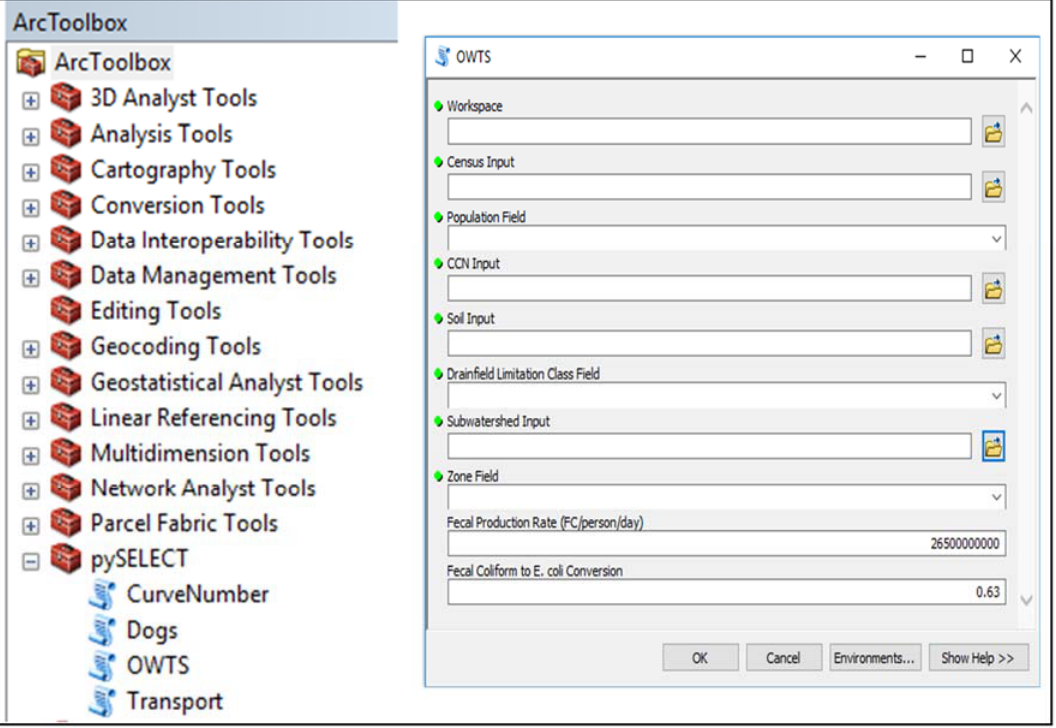
Figure 1. Example of pySELECT graphical user interface (GUI) for the OWTS Figure 1 . Example of pySELECT graphical user interface (GUI) for the OWTS module.